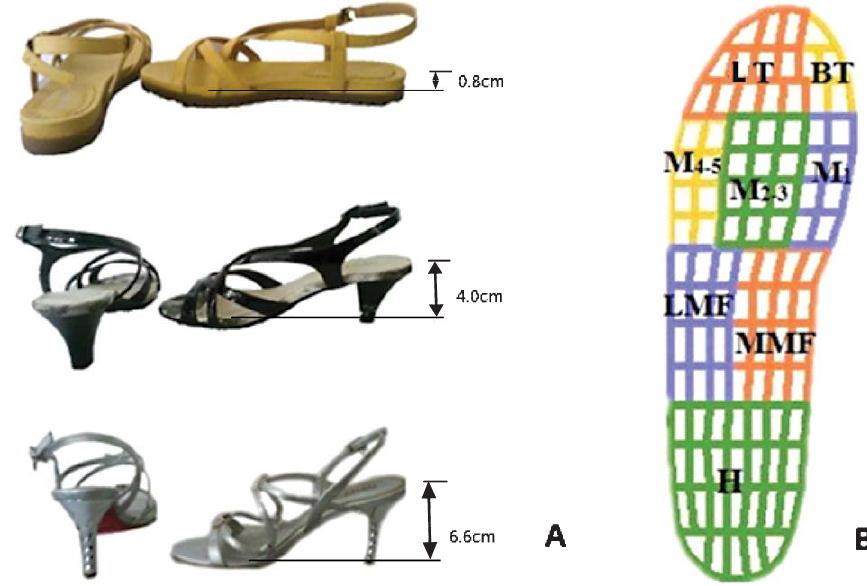
Fig. 1. A: Shoes with different heel height; B: The mask definition of the plantar